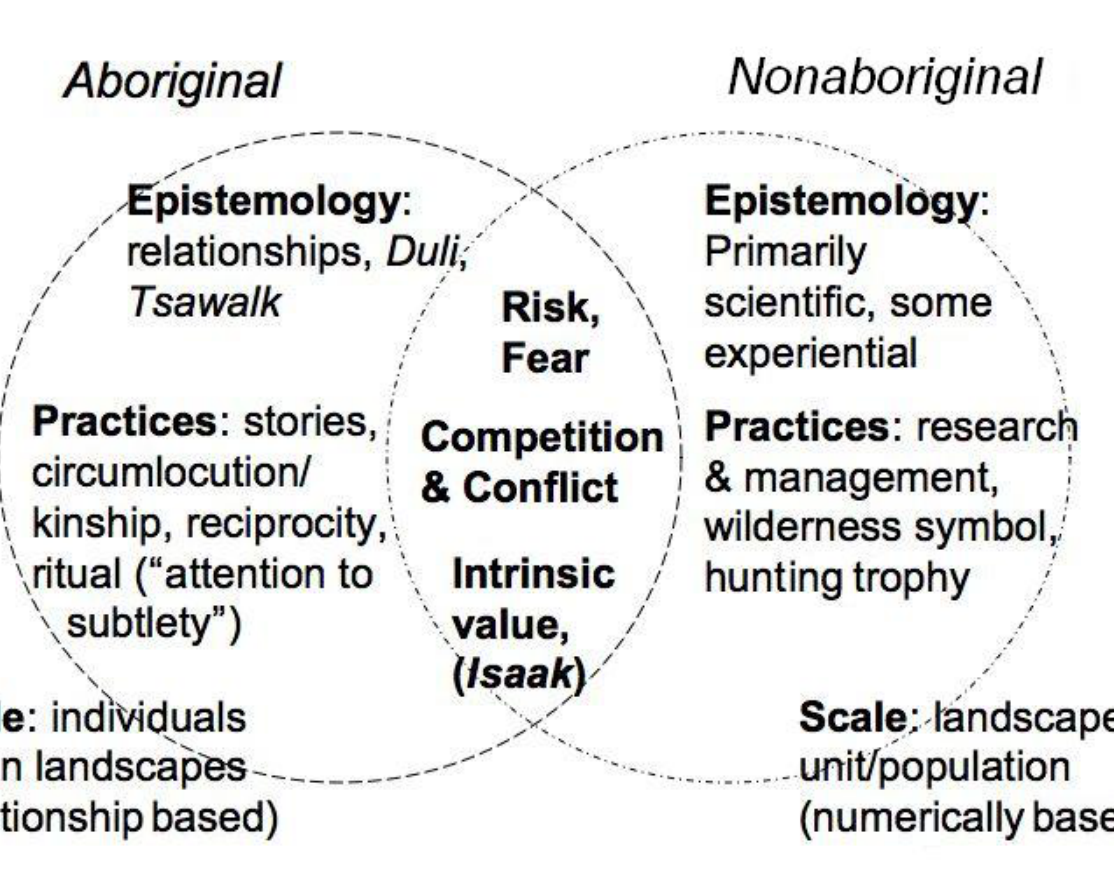
Fig. 2. Observed aspects of respect for bears in Aboriginal and nonaboriginal North American